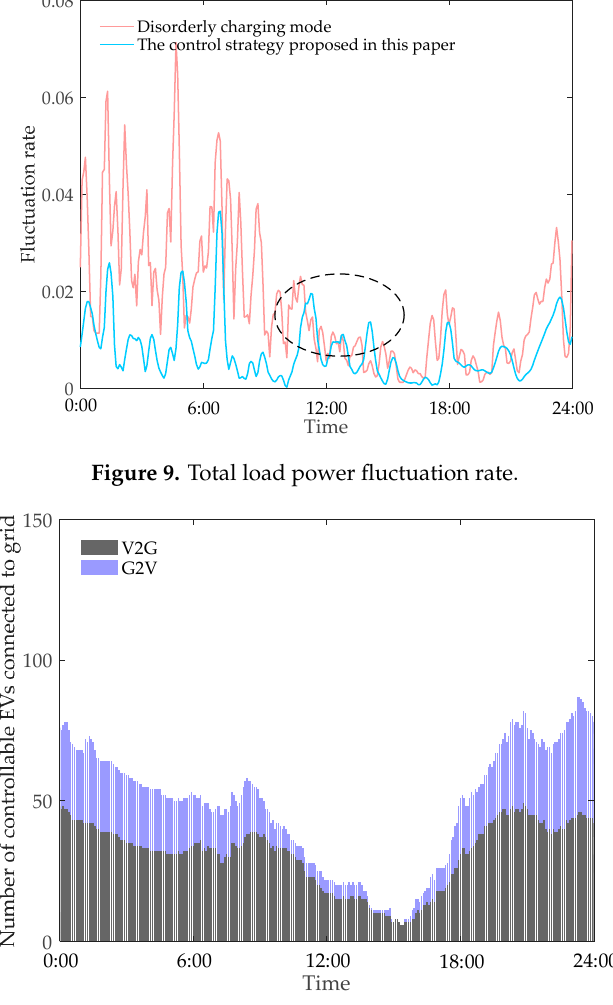
Figure 10. Number of controllable EVs participating in grid scheduling.